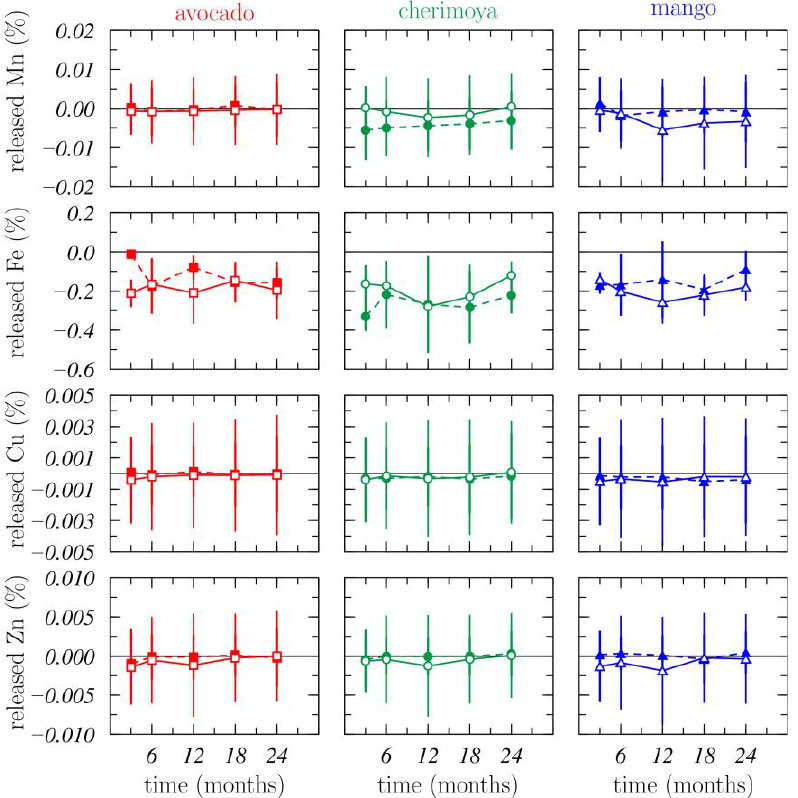
Figure 5. Release of Mn, Fe, Cu, and Zn in each sampling period (3, 6, 12, 18, and 24 months). The solid line represents the concentrations of the garden waste and the broken line the concentration of the subtropical waste in the respective